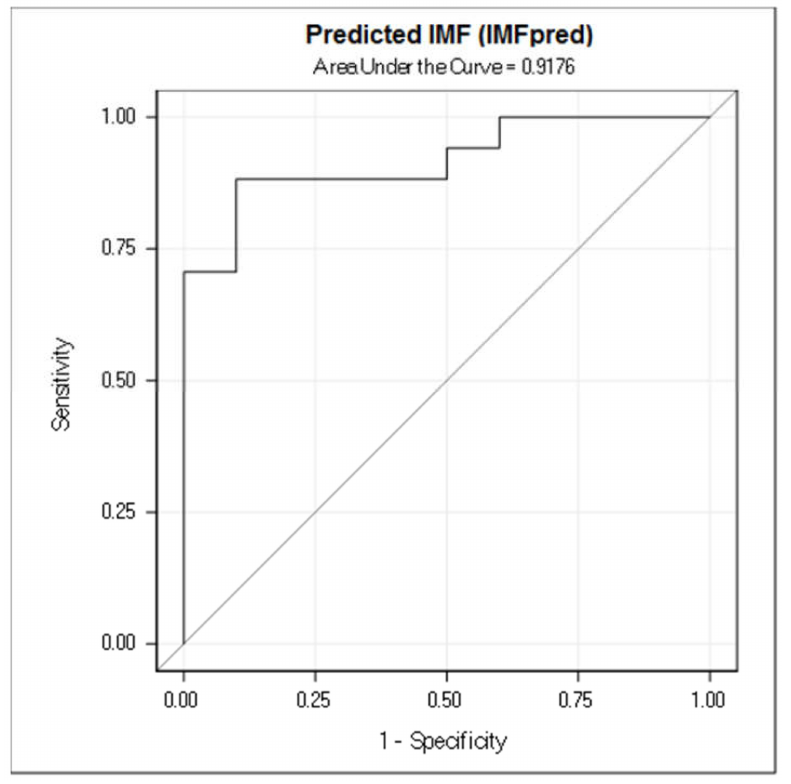
Figure 3. Results of the receiver operator curve (ROC) for the samples. Area Under the Curve = 0.9176 (95% CI: 0.8141–1.0000; positive likelihood ratio 16.9749) using an optimal cut-off value of 4.50 IMF% sensitivity was 88% and the specificity was 90%.